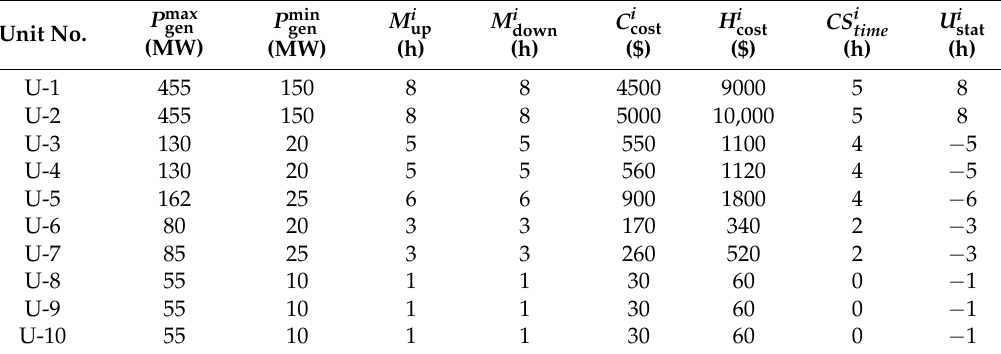
Table 2. Operator data for the 10 unit IEEE 39 bus system.